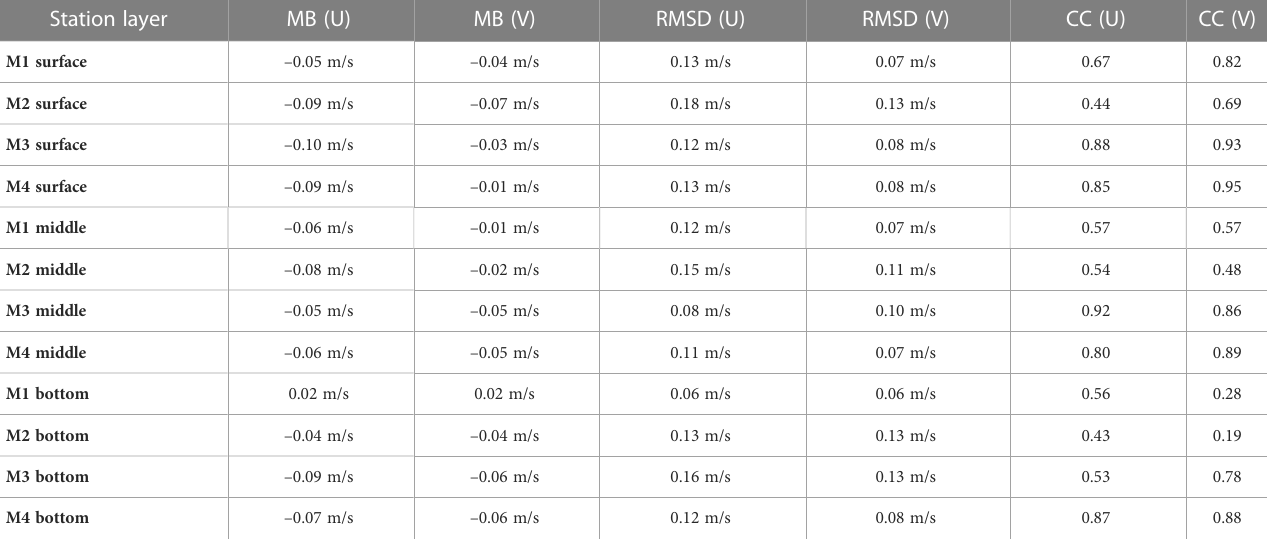
TABLE 1 Basic statistics for current validation between observational data and model outputs.